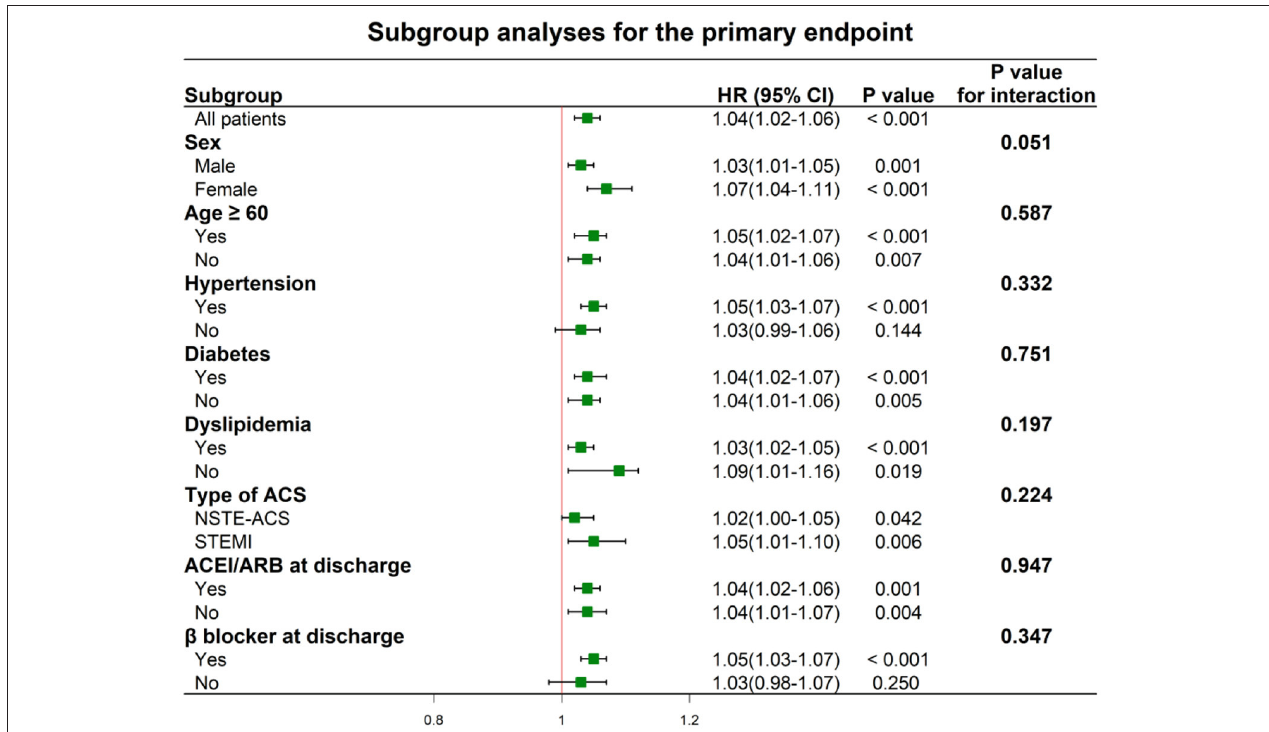
FIGURE 4 | Hazard ratios for the primary endpoint according to the subgroups. ACS, acute coronary syndrome; NSTE-ACS, non ST-segment elevation acute coronary syndrome; STEMI, ST-segment elevation myocardial infarction; ACEI, angiotensin converting enzyme inhibitor; ARB, angiotensin II receptor